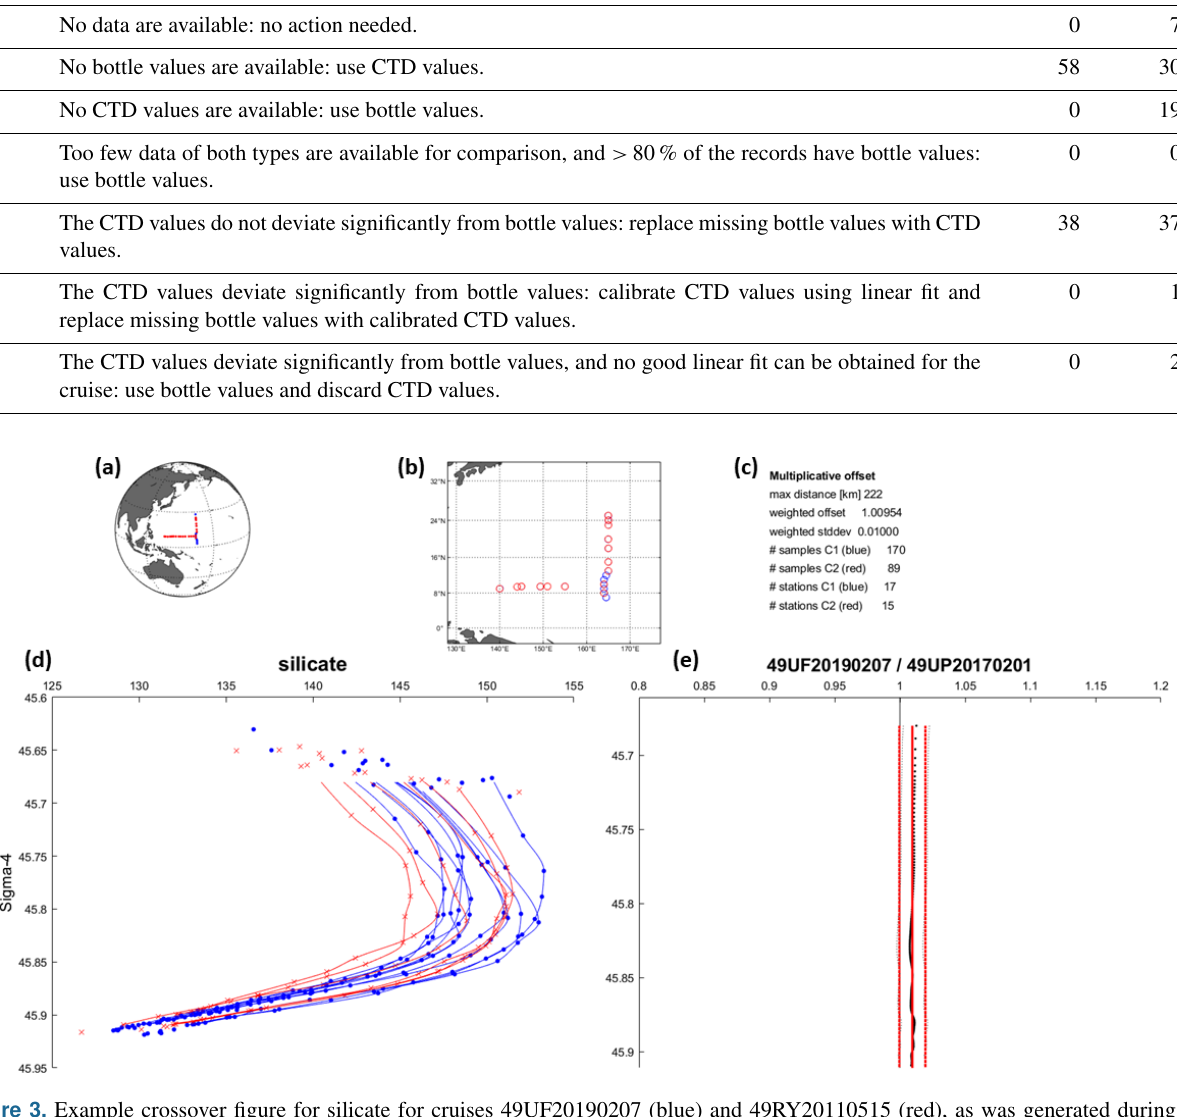
Figure 3. Example crossover figure for silicate for cruises 49UF20190207 (blue) and 49RY20110515 (red), as was generated during the crossover analysis. Panel (a) shows all station positions for the two cruises, and (b) shows the specific stations used for the crossover analysis. Panel (d) shows the data of silicate (µmolkg − 1 ) below the upper depth limit (in this case 2000dbar) versus potential density anomaly referenced to 4000dbar as points and the interpolated profiles as lines. Non-interpolated data either did not meet minimum depth separation requirements (Table 4 in Key et al., 2010) or are the deepest sampling depth. The interpolation does not extrapolate. Panel (e) shows the mean silicate difference profile (black, dots) with its standard deviation, as well as also the weighted mean offset (straight red lines) and weighted standard deviation. Summary statistics are provided in (c)